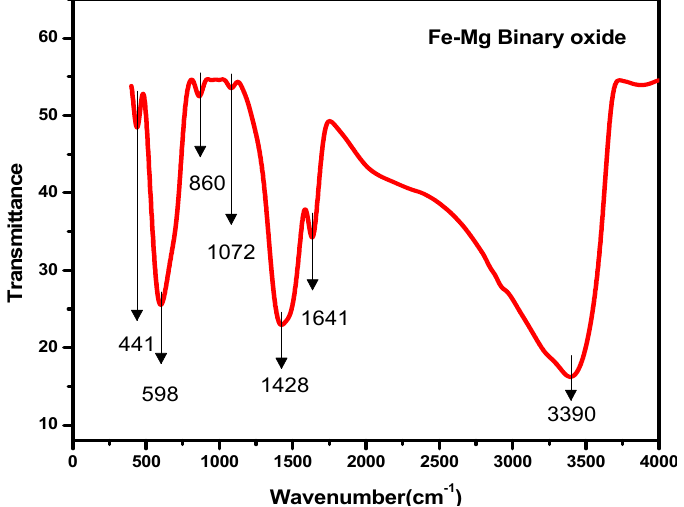
Figure 3. Fourier Transform Infrared Spectroscopy (FTIR) spectrum of Fe-Mg Binary Oxide Nanoparticles.